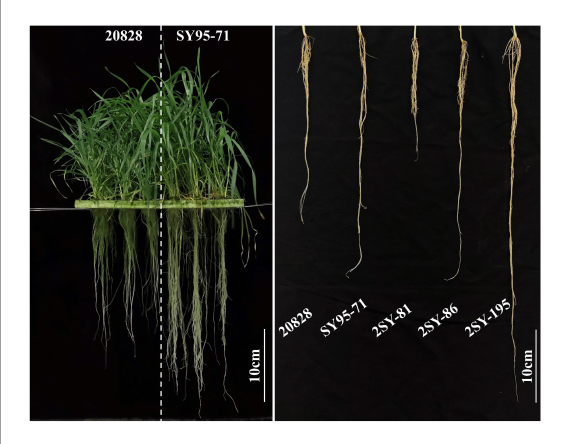
FIGURE1 Maximum root length (MRL) of the parent 20828, SY95-71, and partial RILs. The white bar represents the scale = 10